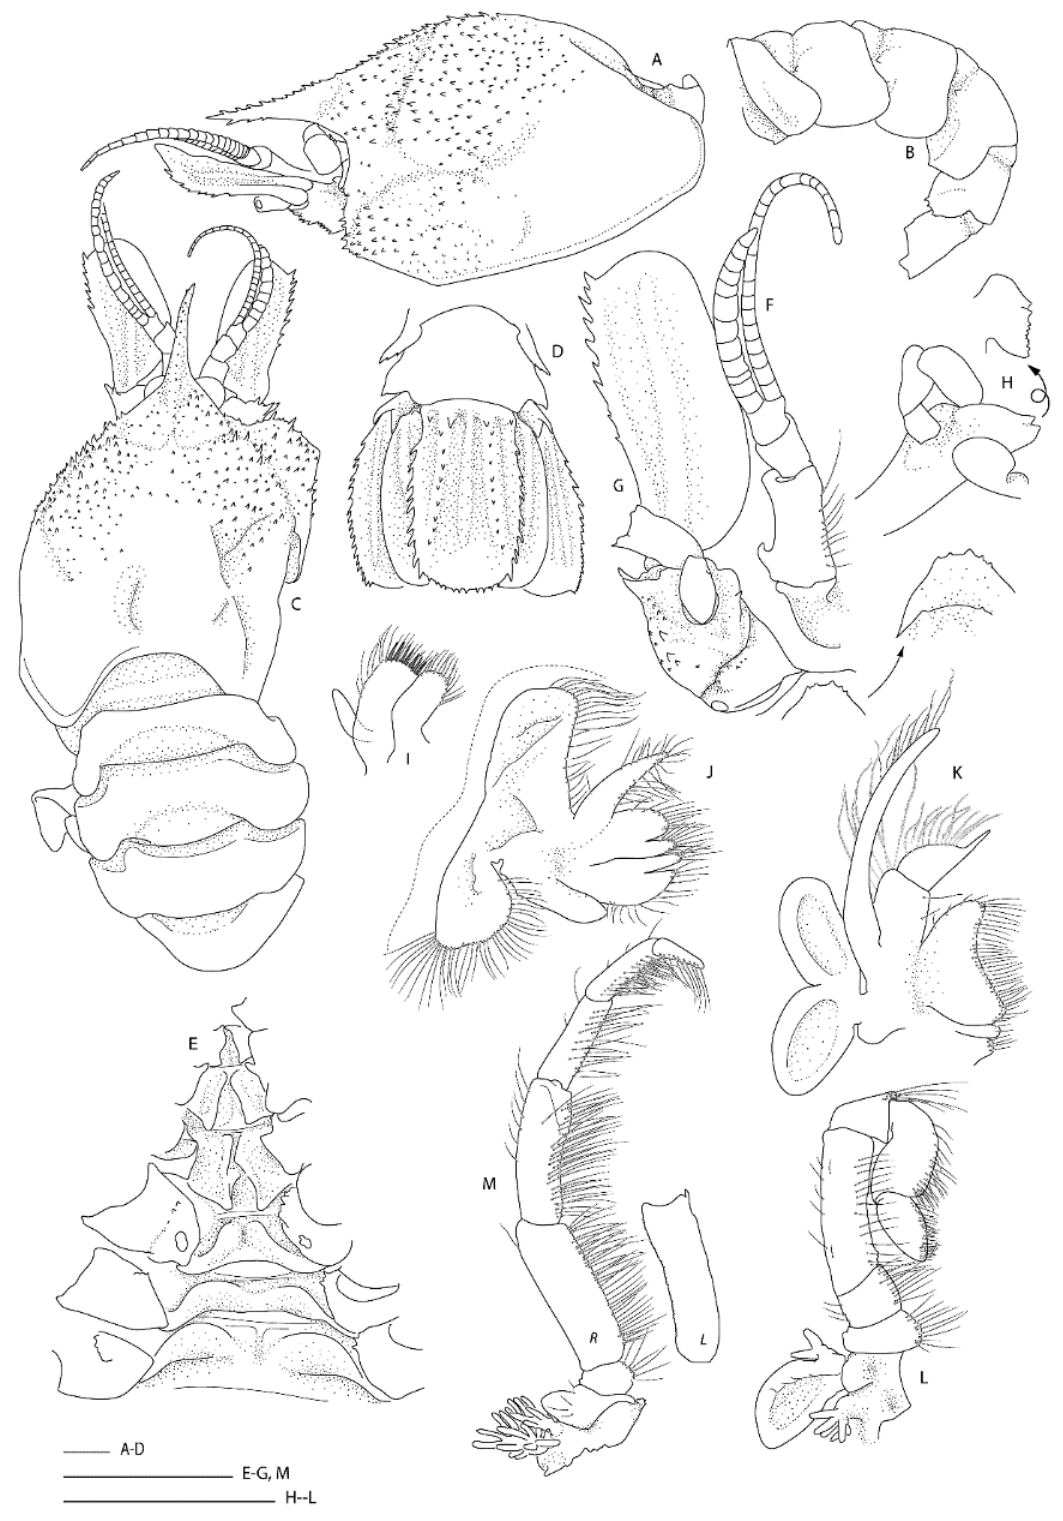
Figure 16. Spongicoloides sonne sp. nov. (NMNZ CR.019650). ( A ) Carapace and cephalic appendages, lateral. ( B ) Pleon, lateral. ( C ) Habitus, dorsal. ( D ) Pleonites 5–6, urosome and telson, dorsal. ( E ) Thoracic sternites with coxae of pereiopods, ventral. ( F ) Right antennule, ventral. ( G ) Right antenna, epistome and labrum, ventral. ( H ) Right mandible with paragnath, outer view, inset with rotated mandibular incisor margin. ( I ) Right maxillule. ( J ) Right maxilla. ( K ) Right Mxp1. ( L ) Right Mxp2. ( M ) Right ( R ) Mxp3 with inset left ( L ) ischium. Scale bars = 2 mm.